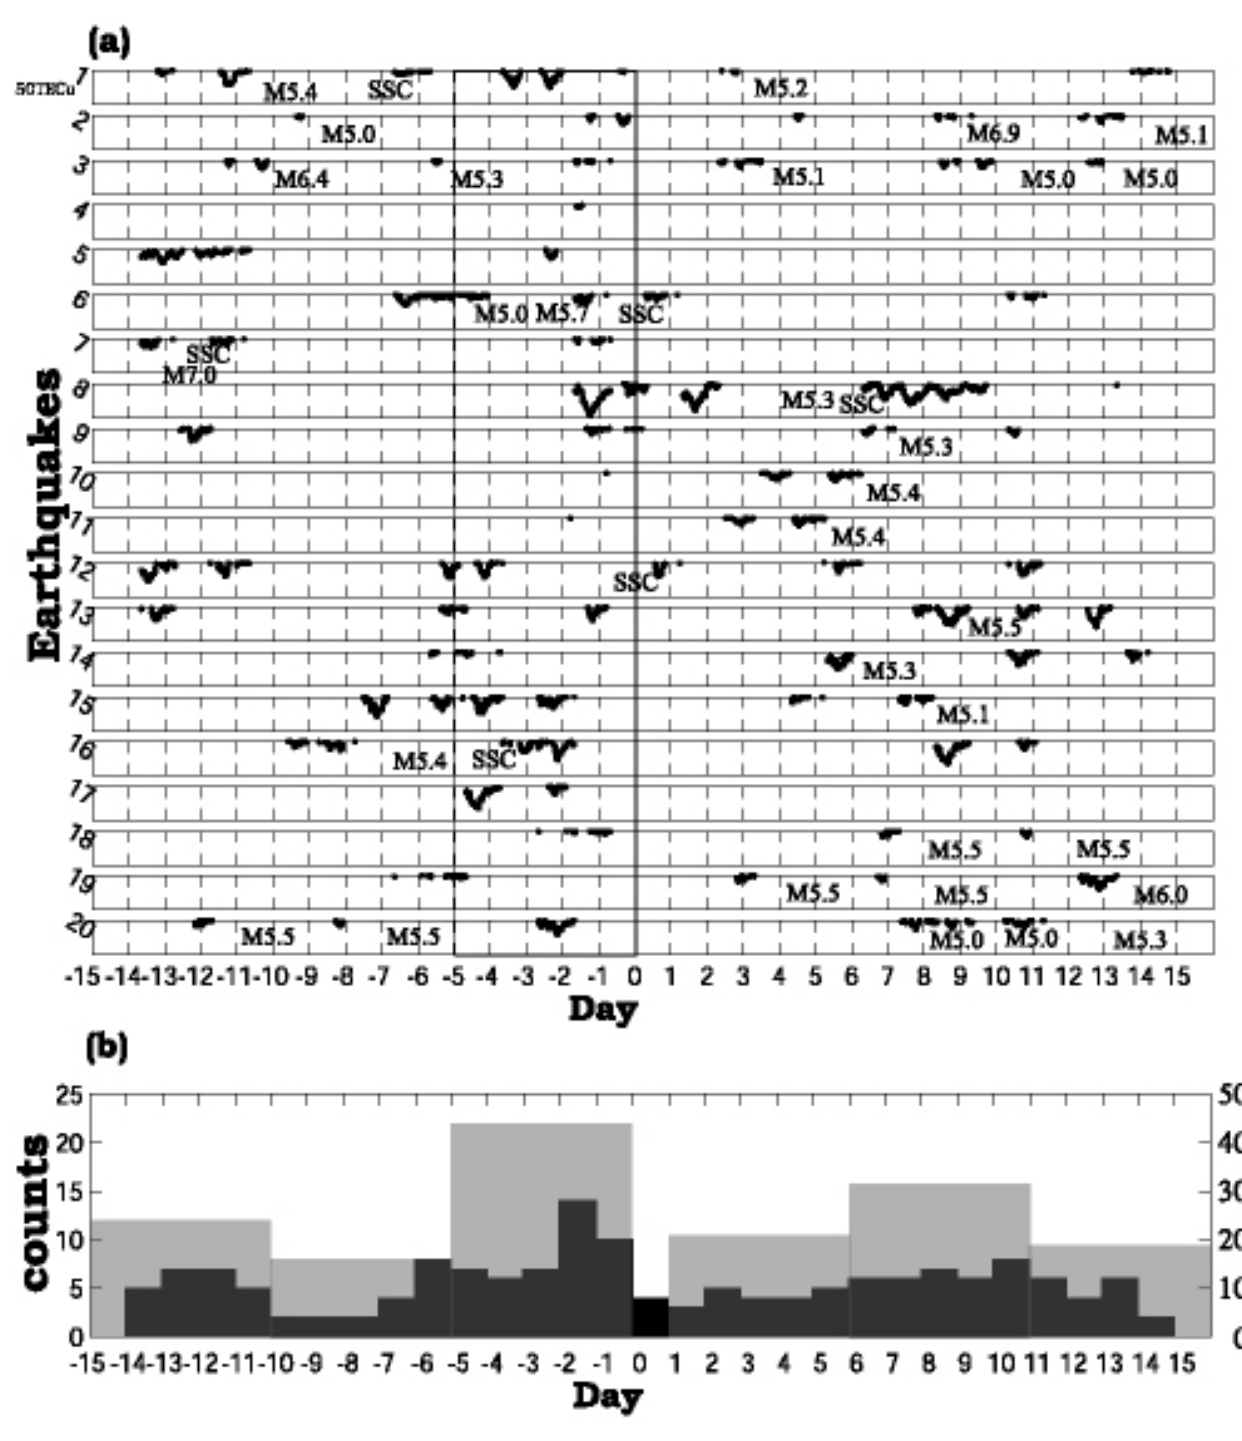
Fig. 4. The lower anomalies that occurred within 15 days before and after the 20M > = 6.0 earthquakes. (a) The observed V T EC exceed the associated lower bound. (b) The counts of lower anomalies appear more than 2h during 12:00–22:00LT for each day (dark histogram, left vertical axis) and every 5-day (gray histogram, right vertical axis). The day is in